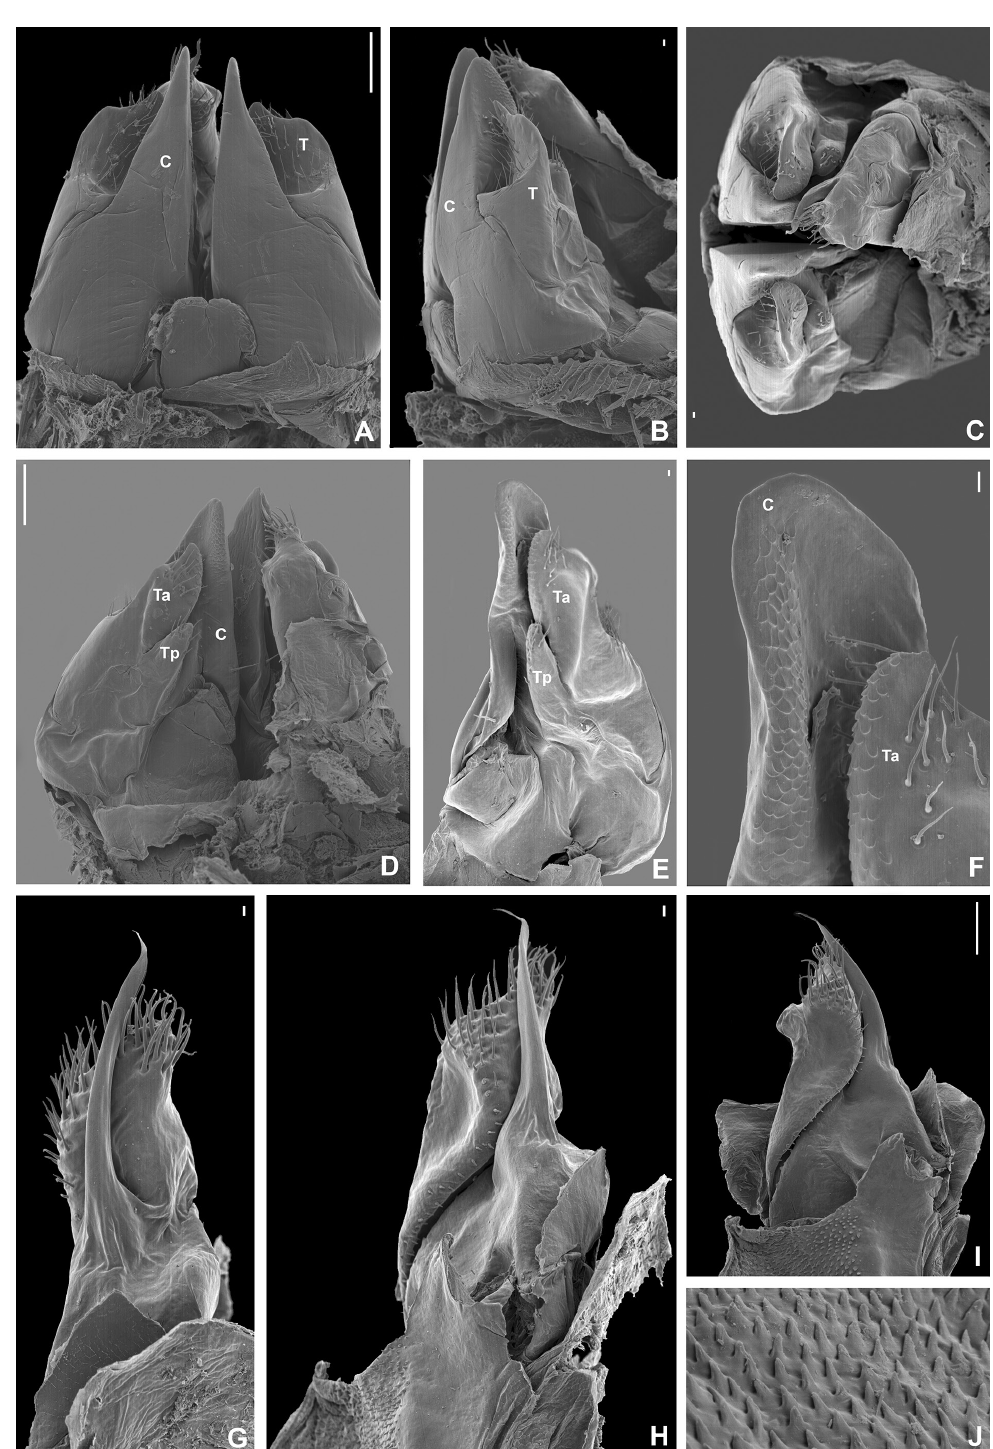
Fig. 5. Chiraziulus kaiseri (Mauriès, 1983), ♂, paratypes, gonopods. Scanning electron micrographs. A . Anterior gonopods in anterior view. B . Anterior gonopods with one posterior gonopod in lateral view. C . As B, in apical view. D . As B, in posterior view. E–F . Anterior gonopod with detail of the processes on the tip of anterior gonopods. G–I . Posterior gonopod. J . Detail of the mesal sternal part. Abbreviations: C = coxal process; T = telepodite; Ta = anterior lobe of telopodite; Tb = posterior lobe of telepodite. Scale bars: A, D, I = 100 μm; B–C, E–H = 10